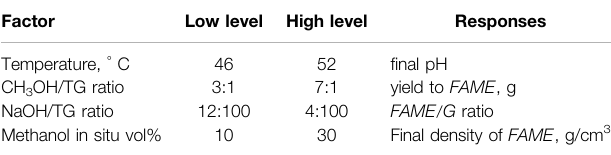
TABLE 2 | Fractional factorial 2 4 − 1 design of